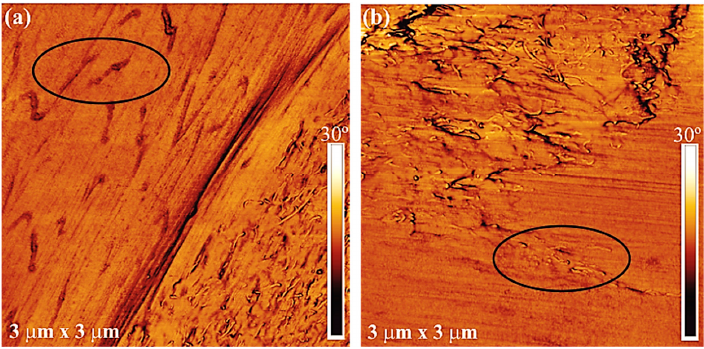
Figure 2. AFM images for the ( a ) 65/28/(6/1) and ( b ) 51/22/(23/4) w/w PCL/PBS/(PC/MWCNTs) blend nanocomposites. It is worth noting that when the PCL/PBS blends were loaded with 1 wt% MWCNTs, the sizes of the dispersed polymer droplets for the 65/28/(6/1) w/w PCL/PBS/(PC/MWCNTs) nanocomposite were smaller than those of the 28/65/(6/1) w/w PCL/PBS/(PC/MWCNTs) nanocomposite. When the PCL/PBS blends were loaded with 4 wt% MWCNTs, the sizes of the dispersed polymer droplets were smaller in the 22/51/(23/4) w/w PCL/PBS/(PC/MWCNTs) nanocomposite than those in the 51/22/(23/4) w/w PCL/PBS/(PC/MWCNTs) blend nanocomposite (Table 2). The smaller droplets indicate that there is compatibilization between the component phases. However, amongst the nanocomposites investigated in this paper, the 22/51/(23/4) PCL/PBS/(PC/MWCNTs) nanocomposite is the one giving the smallest particle sizes of the dispersed phase. This is due to the lower interfacial tension values between PBS and the PC/MWCNTs masterbatch compared to those between PCL and the PC/MWCNTs masterbatch (see Table 3). At equilibrium the particles will likely disperse in the phase where the affinity between the polymer and the nanoparticles is high. The contact angles, total surface energies, as well as their dispersive and polar surface components, were calculated using the Owens-Wendt method [12,27,28] (Equations 1 and 2).